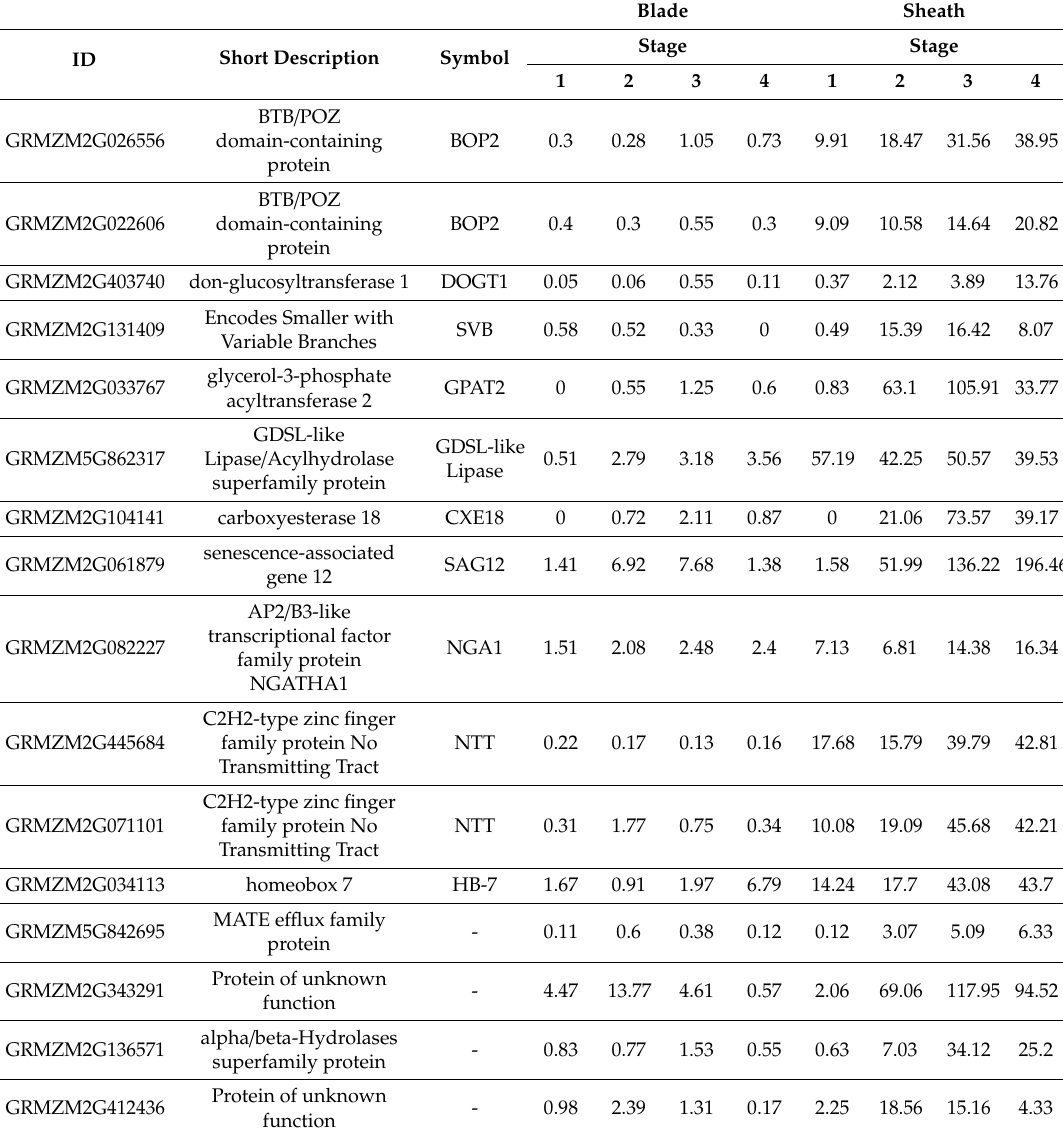
Table 1. Genes expressed at high levels in the sheath